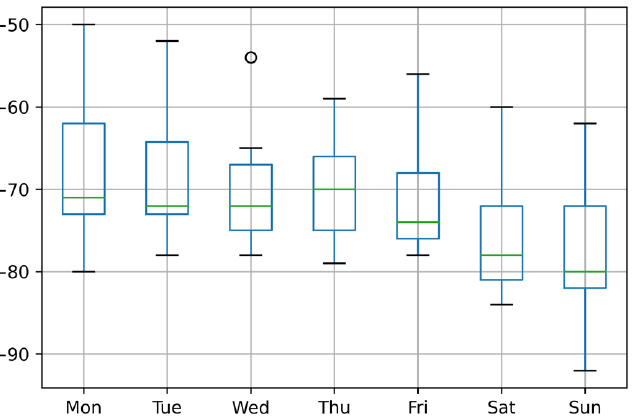
Figure 5. The mobility boxplot of each weekday. The median and Interquartile range (IQR) on weekdays are higher than on weekends, implying that weekly patterns in mobility are closely associated with local lifestyles.